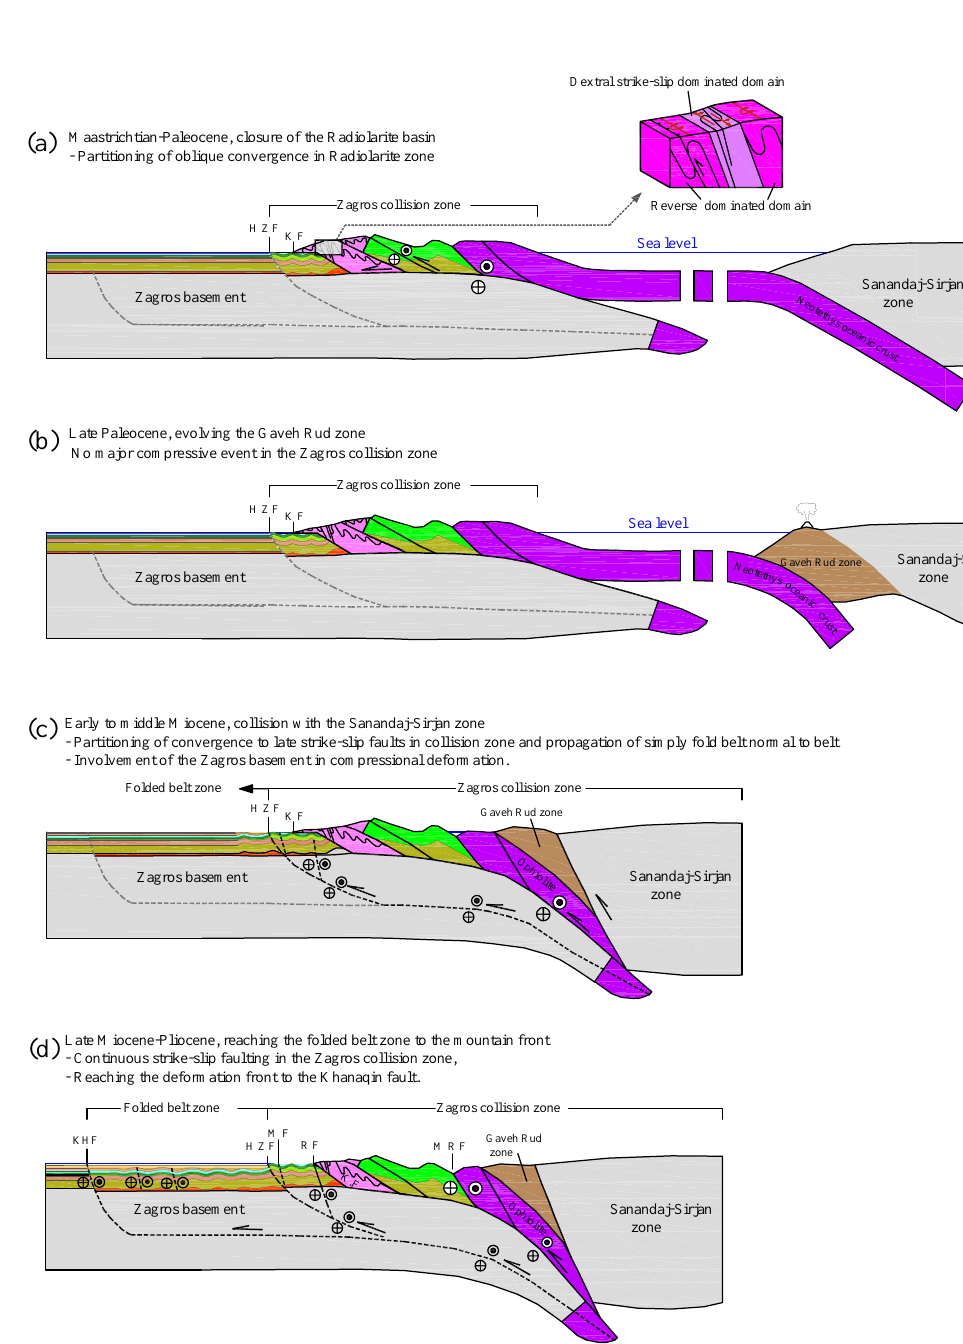
Figure 17. Conceptual model showing different deformation stages for the Zagros oblique convergence since the Late Cretaceous. (a) The obduction resulted in development of the early structures (inset shows the partitioning of oblique convergence into the two dextral strike-slip dominated and reverse dominated domains); (b) The Gaveh Rud zone as the forearc of the Sanandaj–Sirjan zone; (c) evolvement of the Zagros collision zone by emplacement of the Gaveh Rud and Sanandaj–Sirjan zones over the Bisotoun and Radiolarite zones, as well as initiation of the late regional strike-slip faults; (d) propagation of the deformation front toward the Zagros foreland. Not to scale; location of structures is only indicative. Modified and readapted after Agard et al. (2005, 2011), Vergés et al. (2011) and Farahpour and Hessami